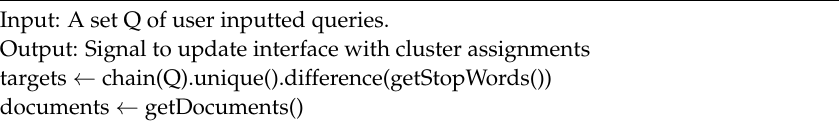
Algorithm 1 Pseudocode of clustering functionality spanning the workflow of